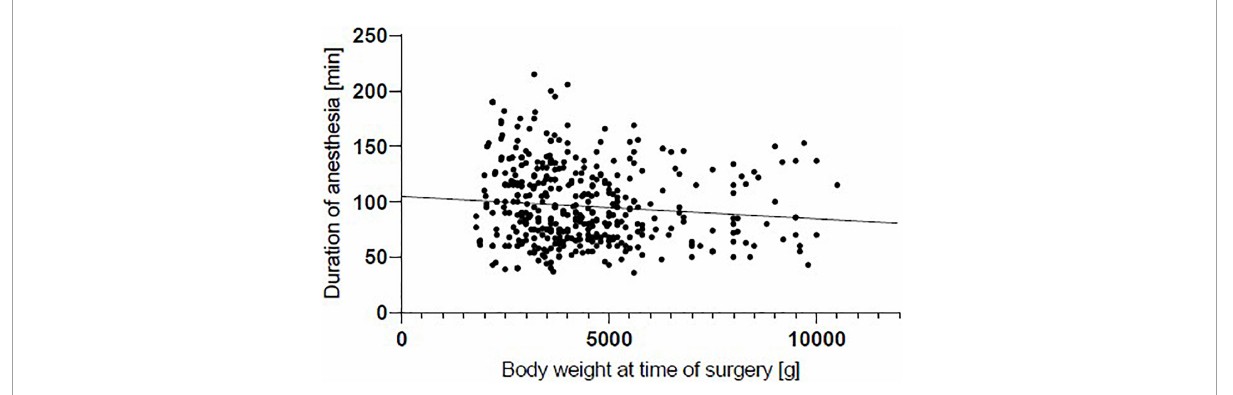
FIGURE1 Correlation between duration of anesthesia and weight at time of surgery. Negative correlation shows that duration of anesthesia decreases with increasing body weight ( p < 0.05; r = –0.135).